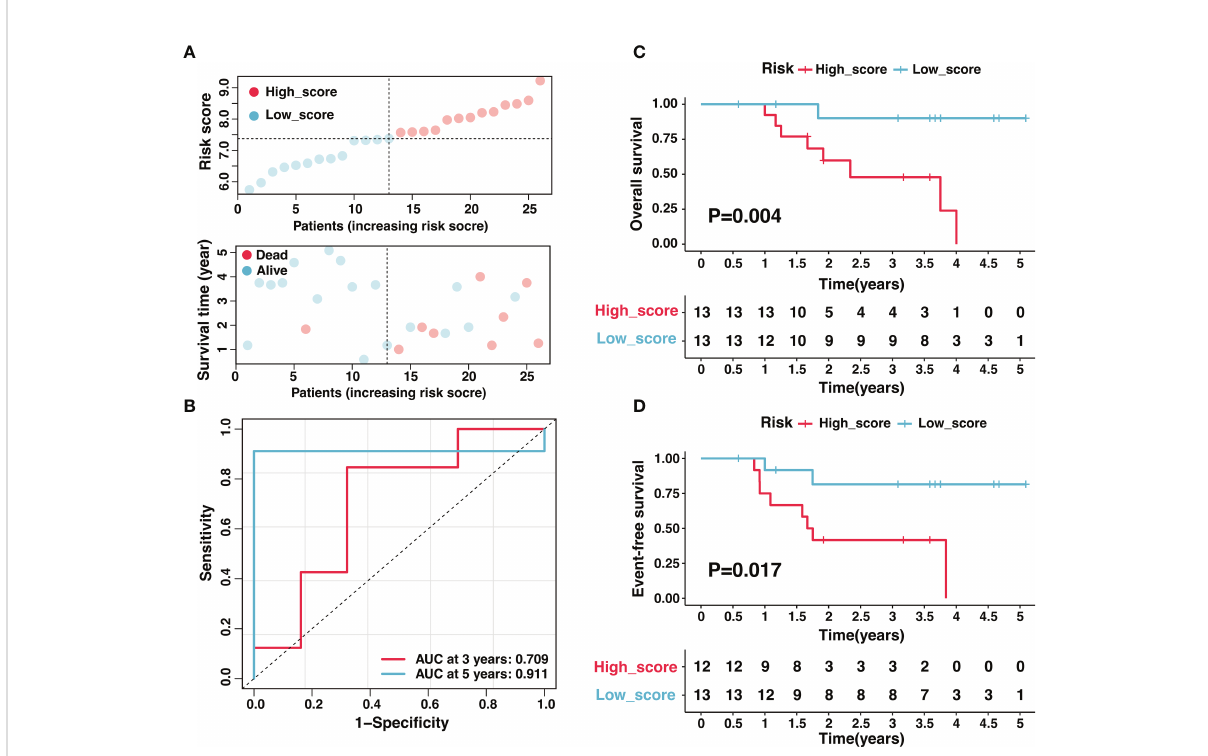
FIGURE 5 Validation of the ganglioside-related risk signature in the Tianjin cohort. (A) The distribution of the risk score (top) and survival time (bottom) in the Tianjin cohort. (B) The ROC curves of the risk signature for 3-year and 5-year OS prediction in the Tianjin cohort. (C, D) Kaplan – Meier curves of overall survival (C) and event-free survival (D) in Tianjin cohort between different risk